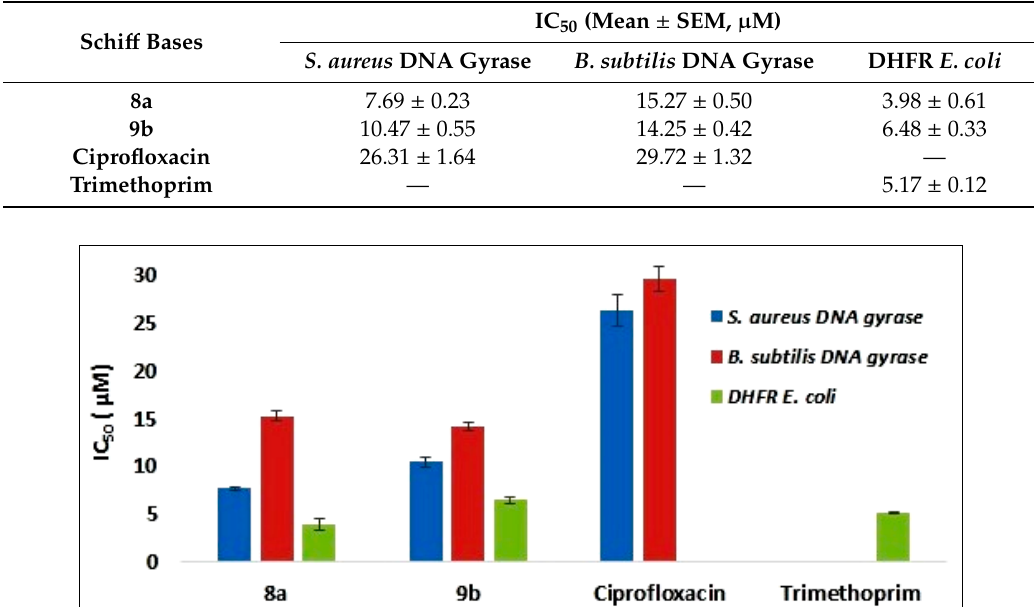
Figure 3. The inhibitory activities (IC 50 , µM) of the two Schiff bases ( 8a and 9b ) and reference drugs against DNA gyrase and dihydrofolate reductase (DHFR).